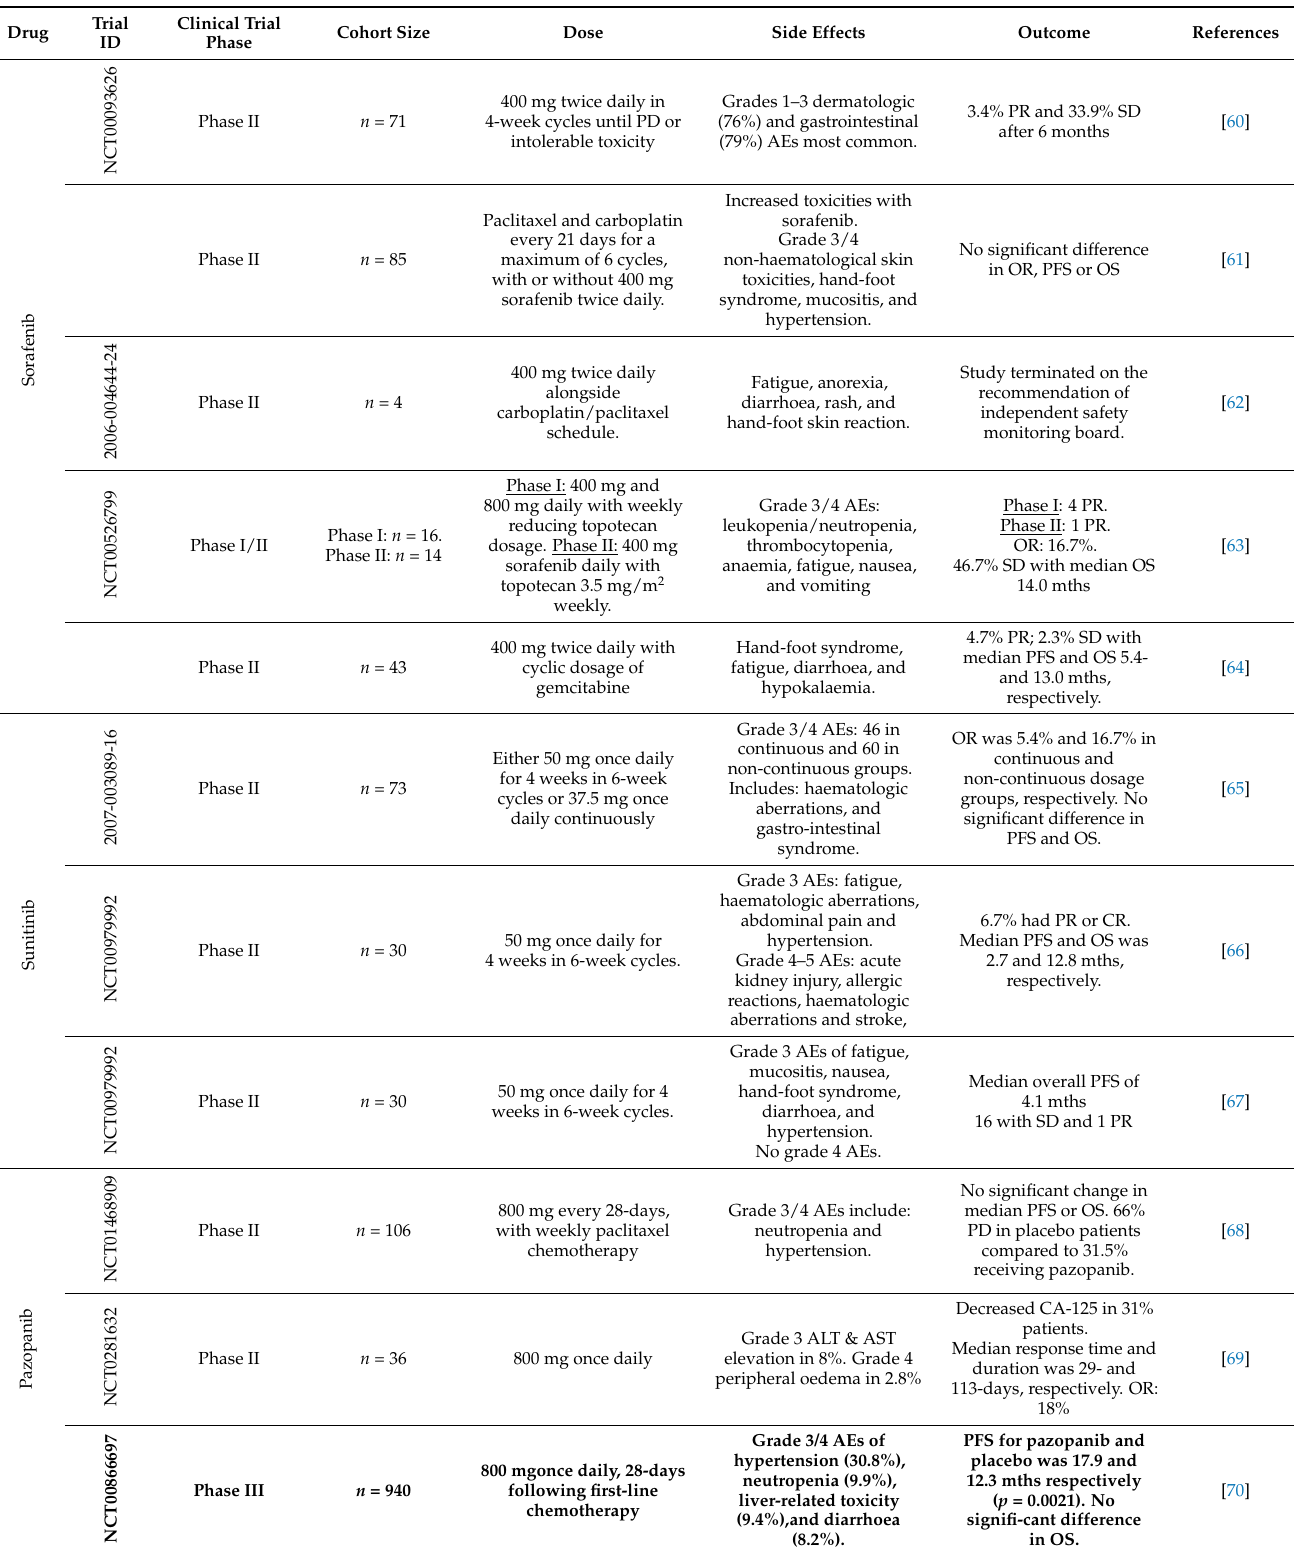
Table 1. Clinical trials involving small molecule tyrosine kinase inhibitors in ovarian